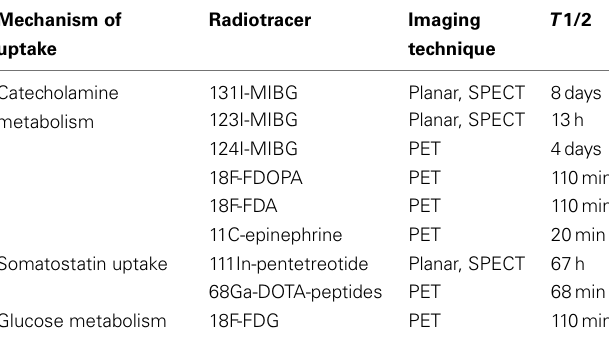
Table 1 | Radiotracers used in functional imaging of